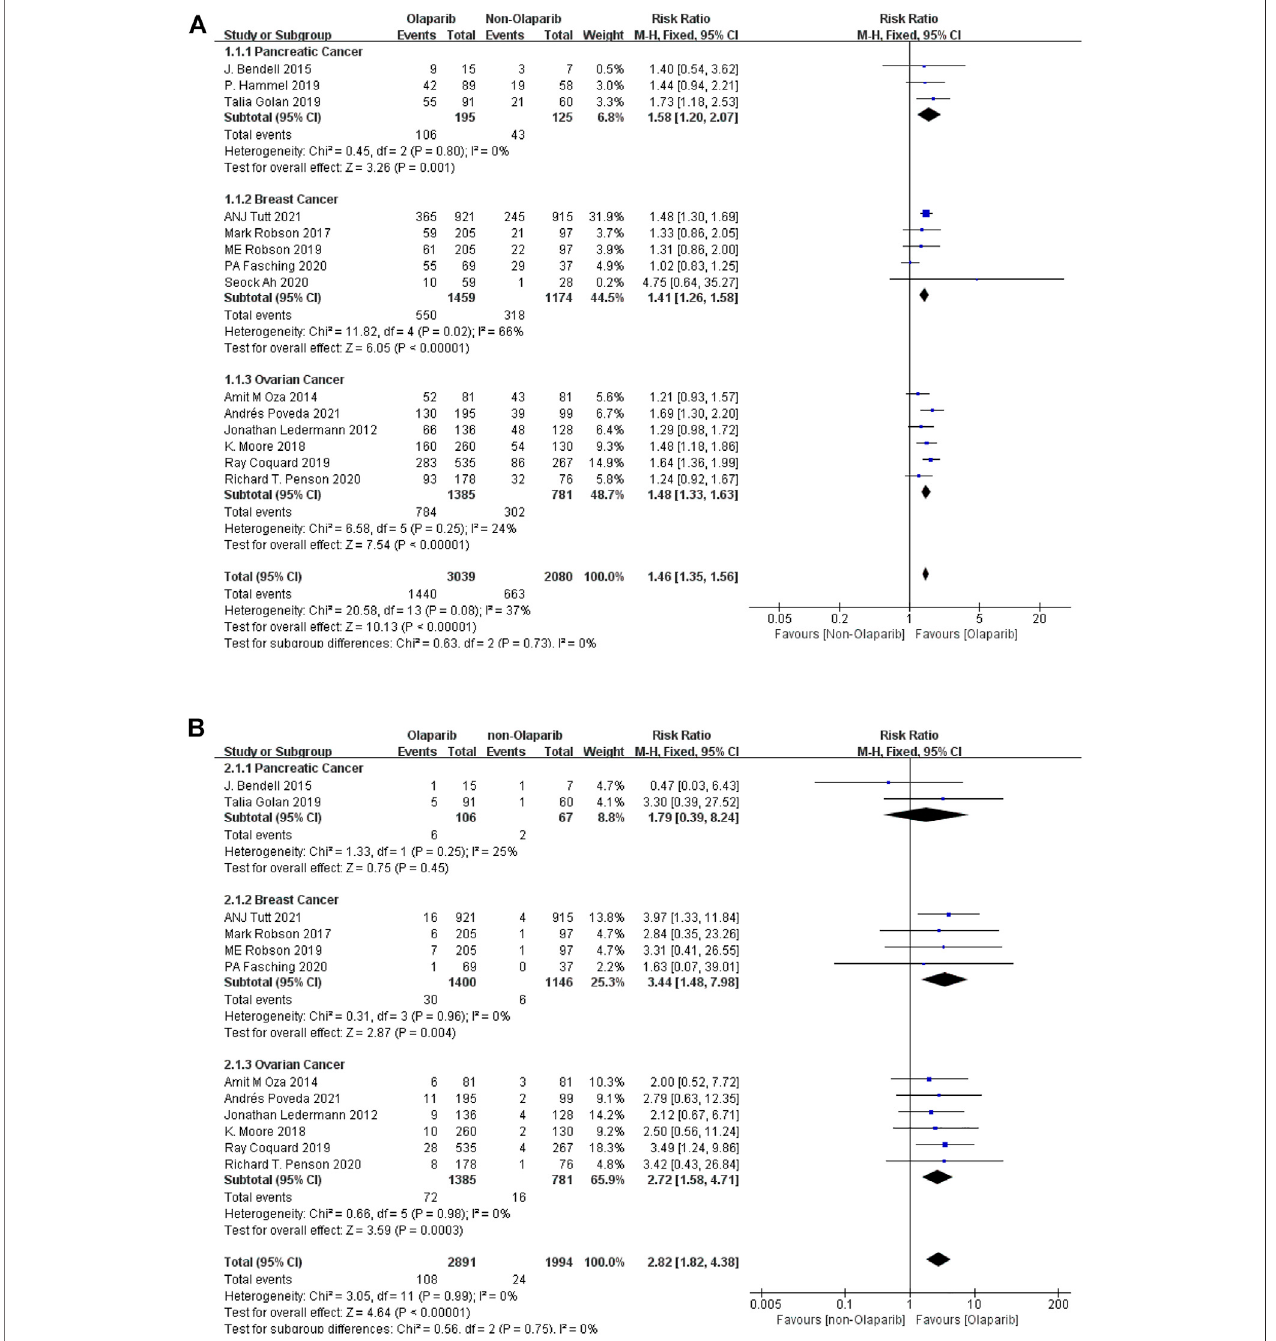
FIGURE2|(A) Meta-analysis ofany-gradeadverse reactionsoffatiguecausedbyOlaparib for differentindications. (B) Meta-analysis ofgrade3or above adverse reactions of fatigue caused by Olaparib for different